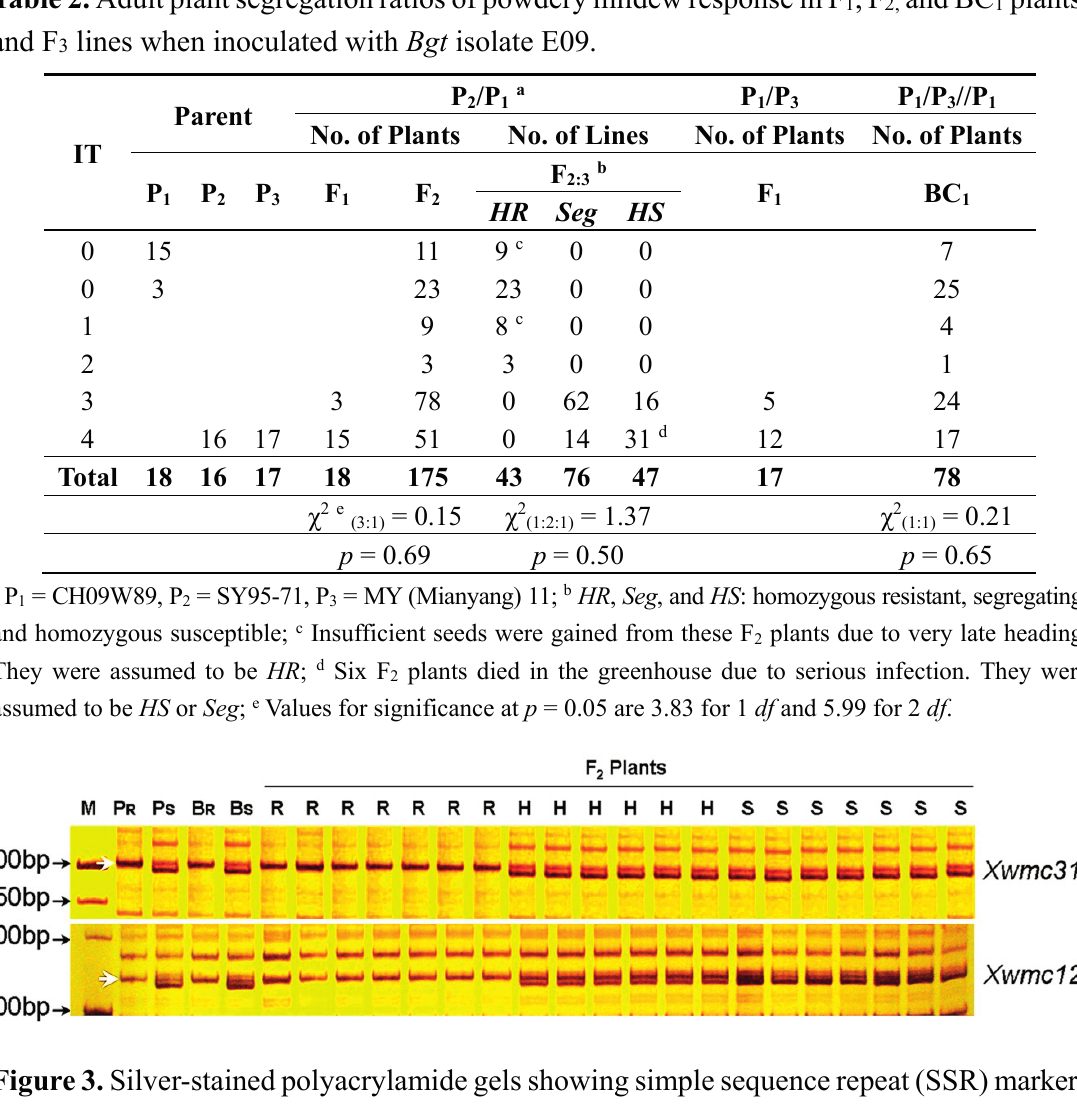
Figure 3. Silver-stained polyacrylamide gels showing simple sequence repeat (SSR) markers Xwmc310 and Xwmc125 flanking the pmCH89 locus. P R and P S denote CH09W89 and SY95-71, respectively; B R and B S denote the resistant and susceptible bulks, respectively. Selected homozygous resistant ( R ), homozygous susceptible ( S ), and heterozygous ( H ) F 2 plants from SY95-71/CH09W89 are included here. M , 100 bp DNA ladder; arrows on the left side indicate the fragment linked to the resistance gene. Arrows indicate the polymorphic